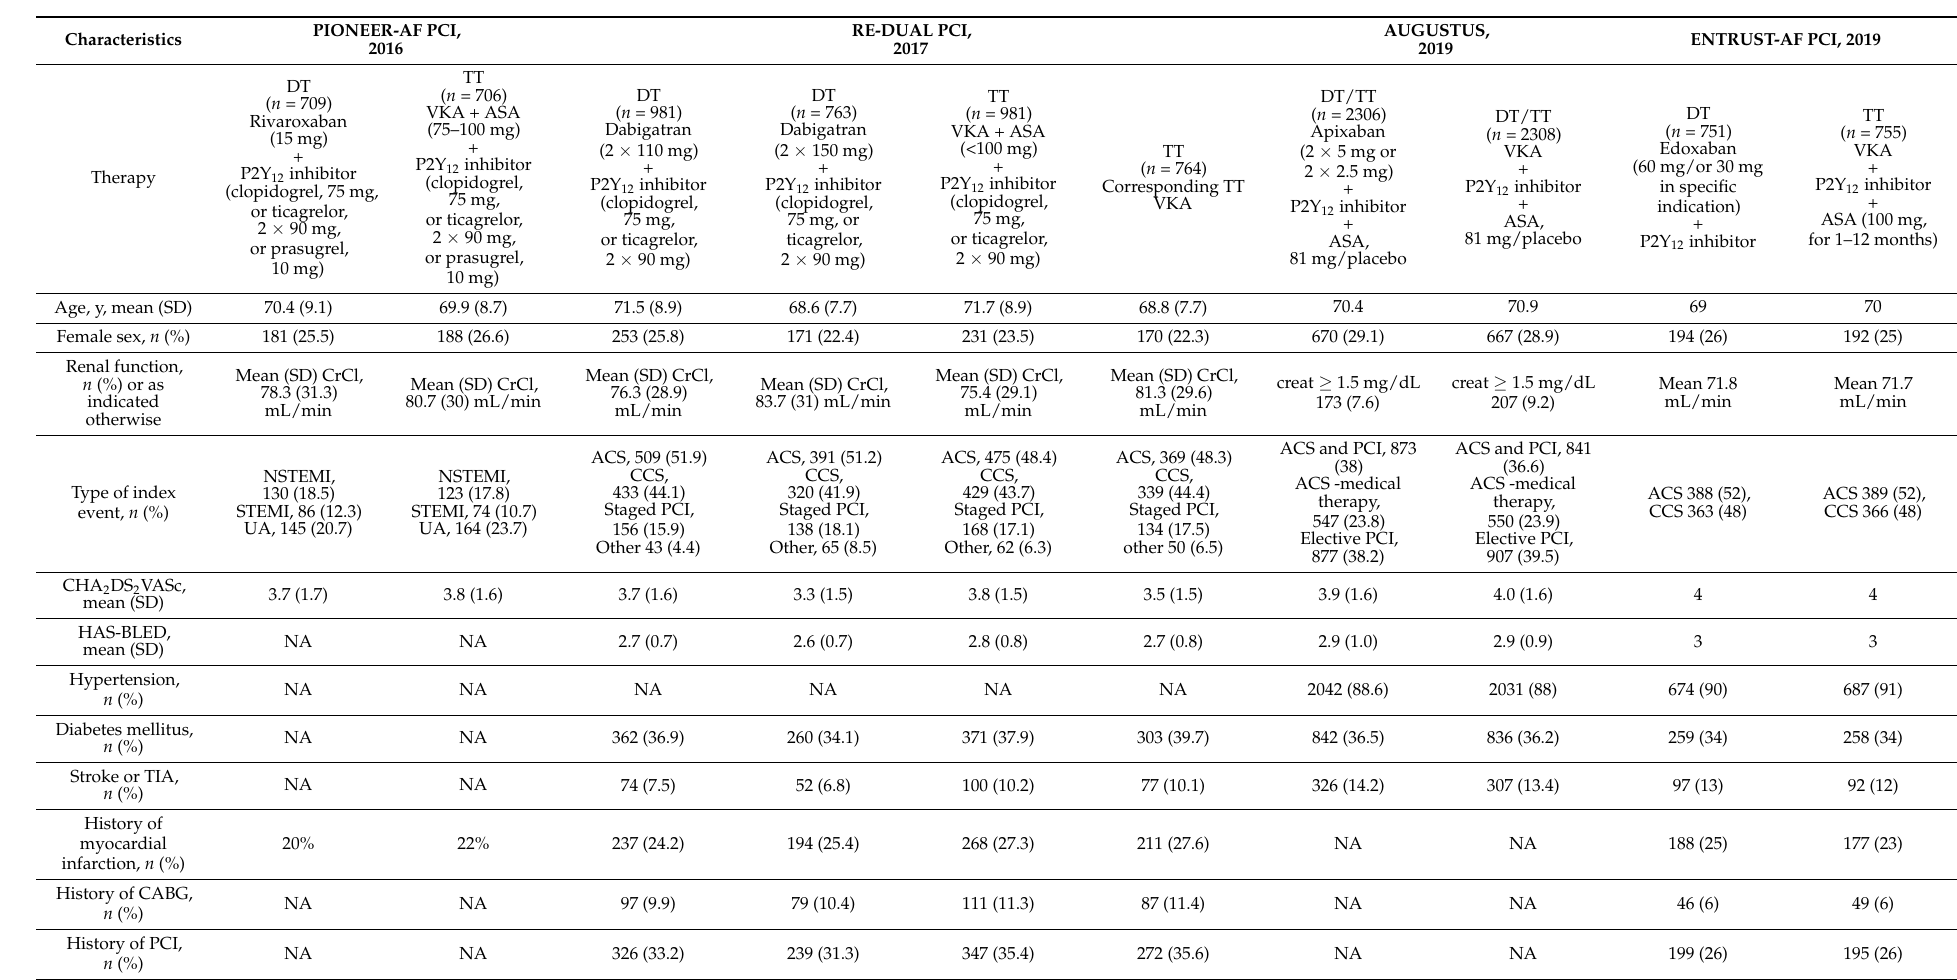
Table 2. Characteristics of patients in clinical trials included in the meta-analysis and treated with